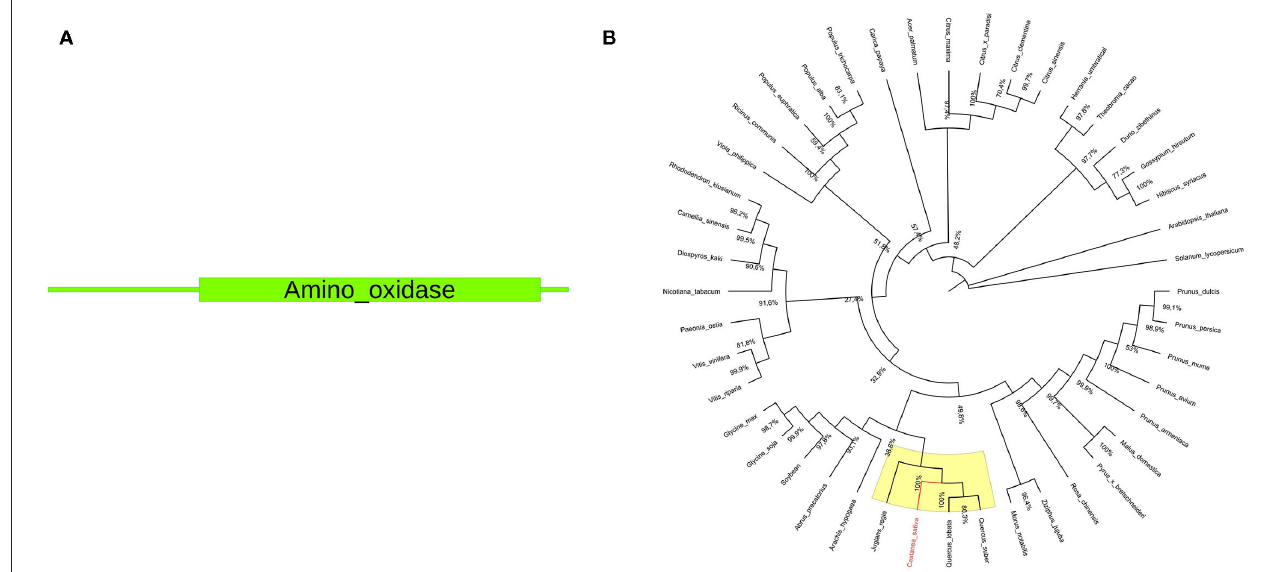
FIGURE 2 | (A) Structural domains of Cspds . The amino_oxidase domain (PF01593) ranges from 71 to 467 amino acids. (B) Phylogenetic analysis of pds gene. The phylogenetic tree was constructed using MEGA X software by aligning chestnut pds coding sequences with NCBI S-gene ortholog coding sequences. The yellow color indicates the Castanea sativa clade. The C. sativa sequence is highlighted in red